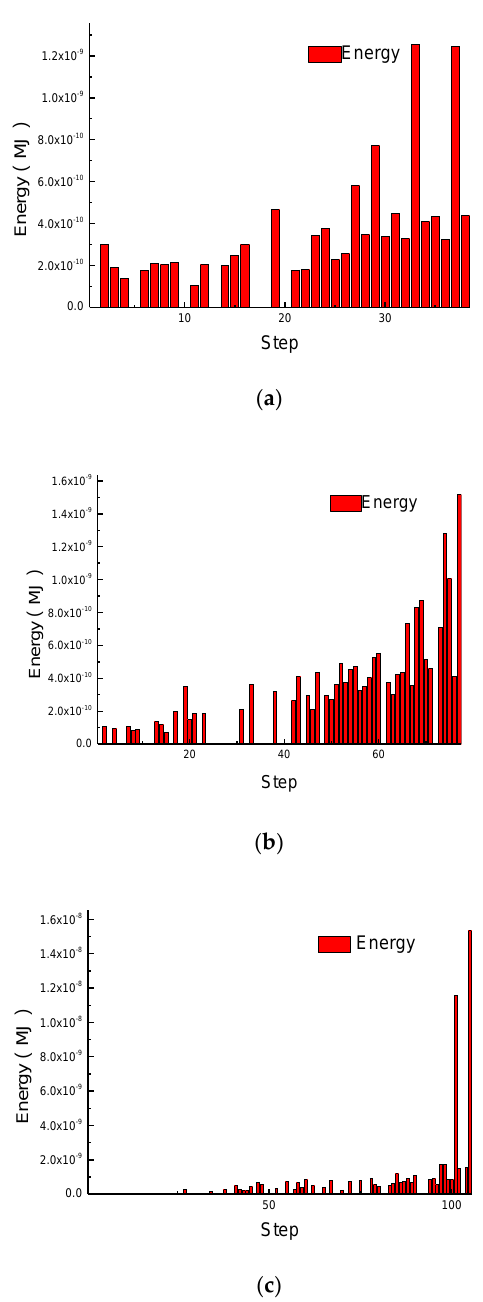
Figure 11. Acoustic emission (AE) energy diagram of coal samples. ( a ) Acoustic emission energy change at σ = 2 MPa; ( b ) acoustic emission energy change at σ = 3 MPa; ( c ) acoustic emission energy change at σ = 4